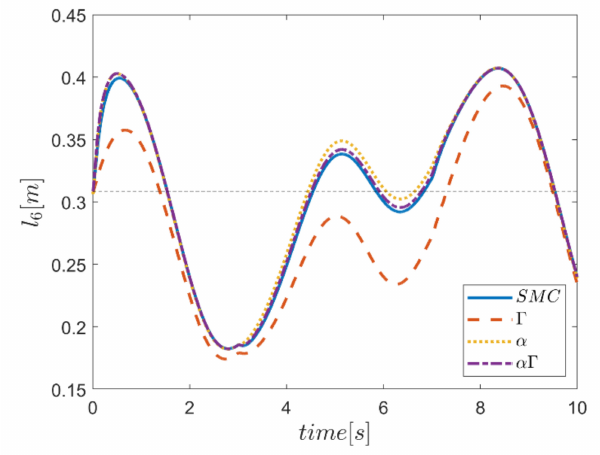
Figure 61. Comparison of the length of the sixth